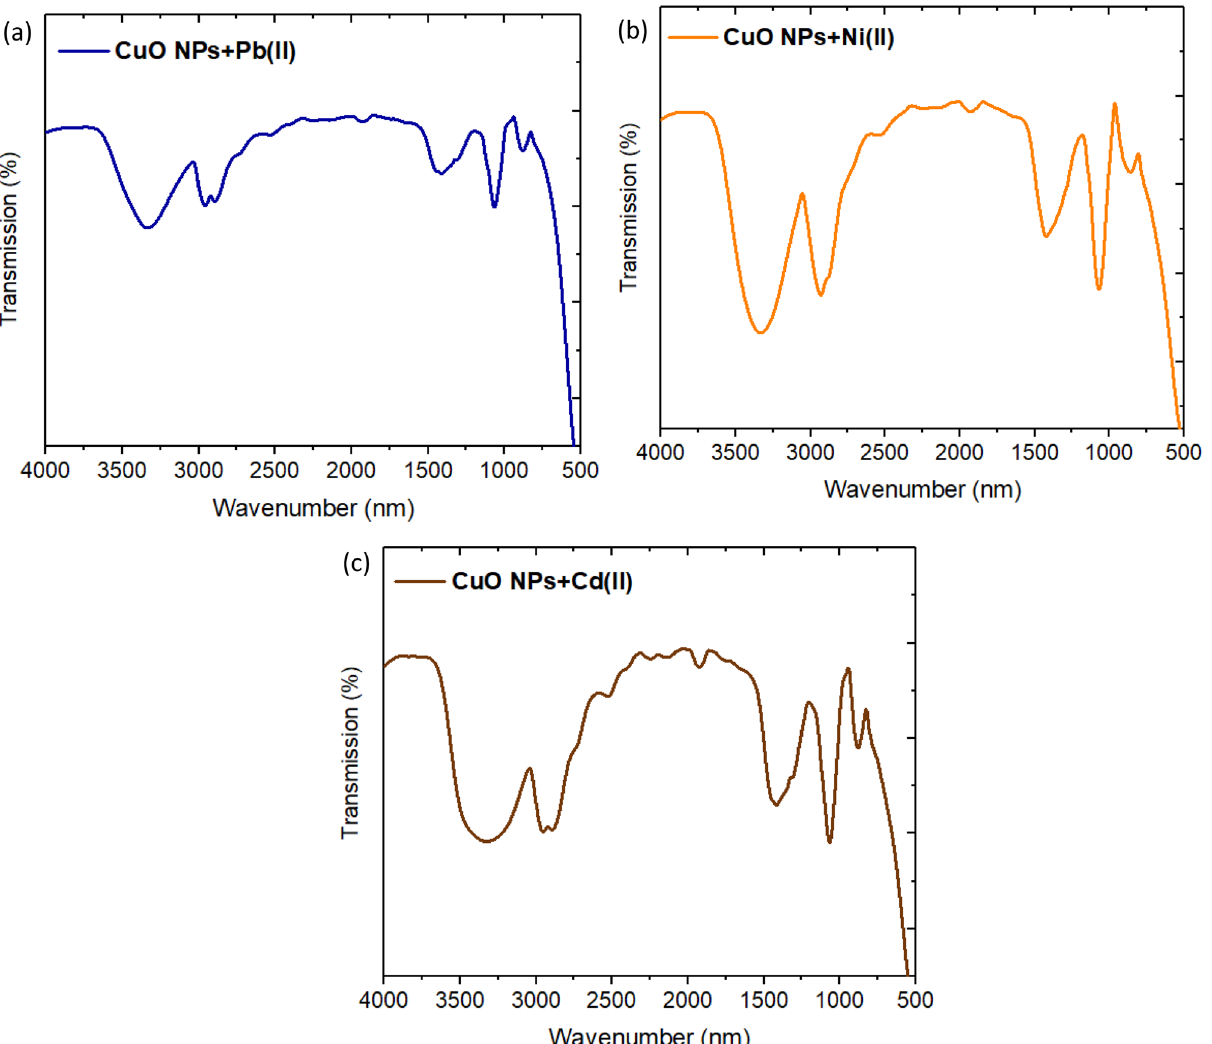
Figure 8. FT-IR Spectra of CuO NPs after adsorption of ( a ) Pb(II), ( b ) Ni(II), and ( c )